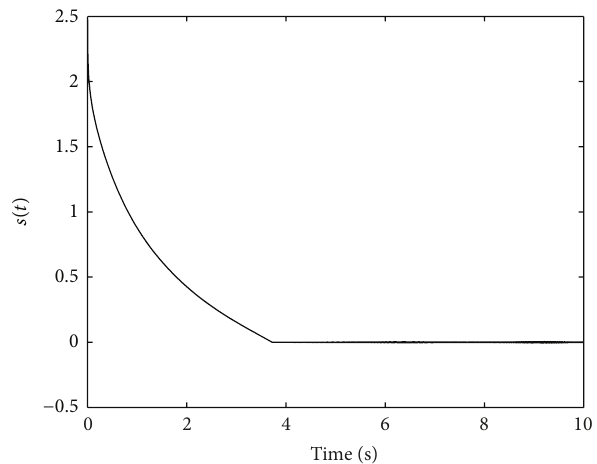
Figure 3: Time history of fractional sliding mode with the control input (27).